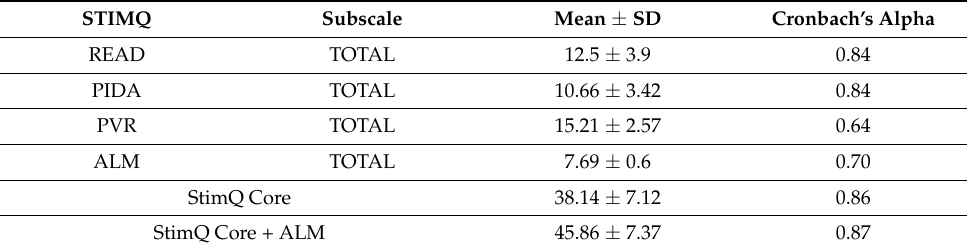
Table 4. Cronbach’s alpha of subscale and total scores for